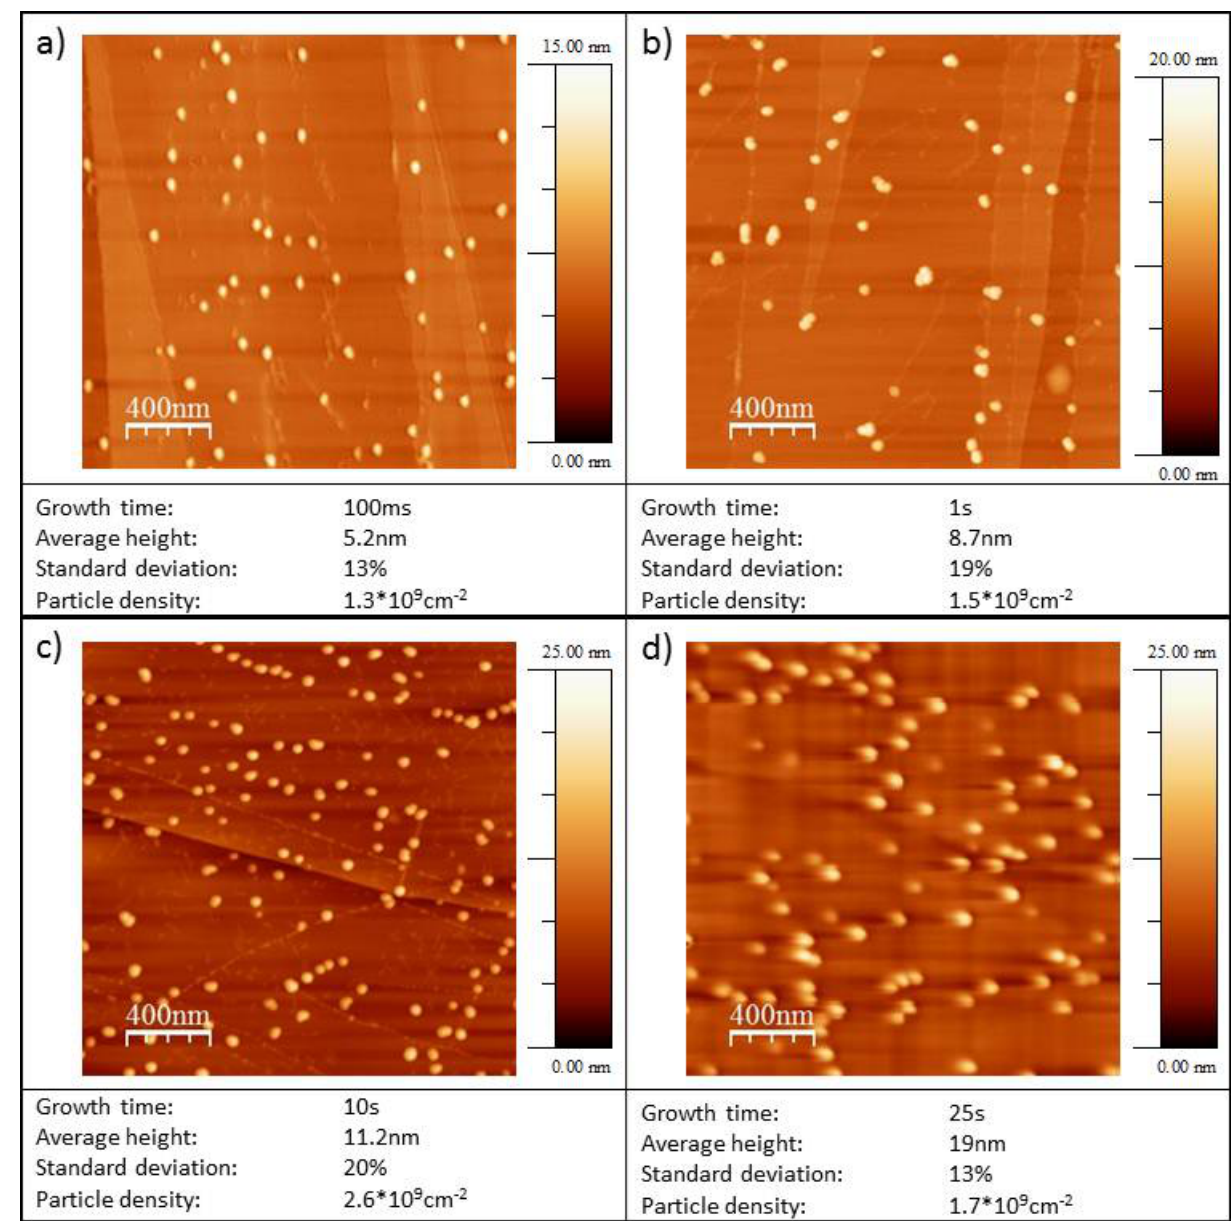
Figure 2. TM-AFM micrographs of Au nanoparticles on HOPG. The deposition parameters were: Nucleation pulse: 31 ms, − 40 mV vs. NHE, growth pulse: Variable duration as given in micrograph captions, 1.085 V vs.